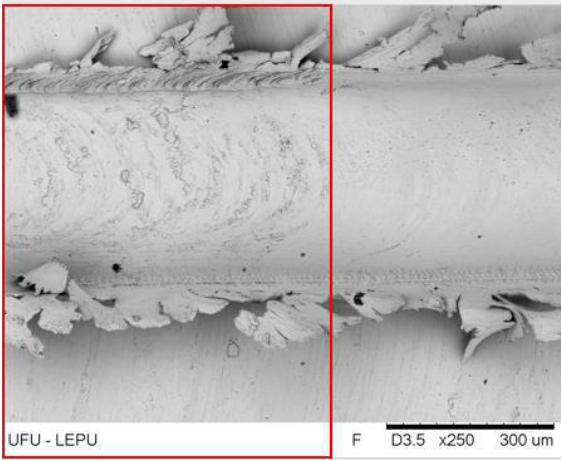
Figure 3: Micromilled slot with different surface finish due to the lack of cutting fluid